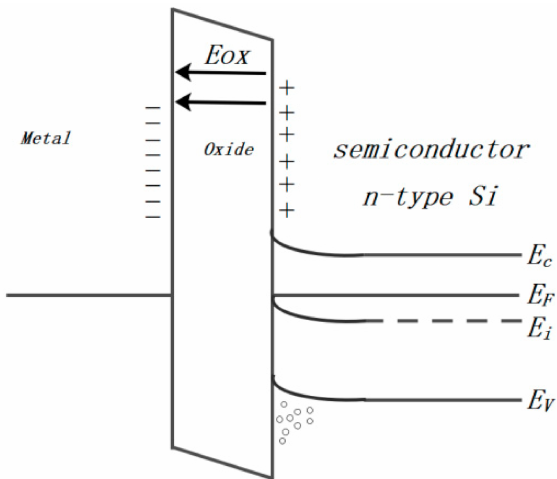
Figure A2. The energy band becomes balanced and built-in field arises due to charge motion. The voltage drop across oxide is the flat band voltage ( V FB ) of MOS.